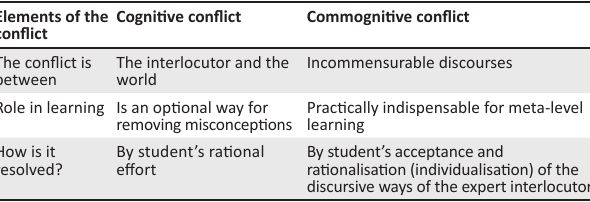
TABLE 2: Comparing cognitive conflict and commognitive